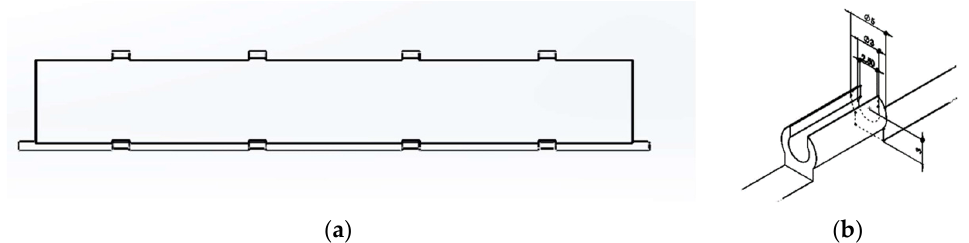
Figure 7. Details of the shutter-like system. From left to right: ( a ) the modular element and ( b ) the hinge knuckle.